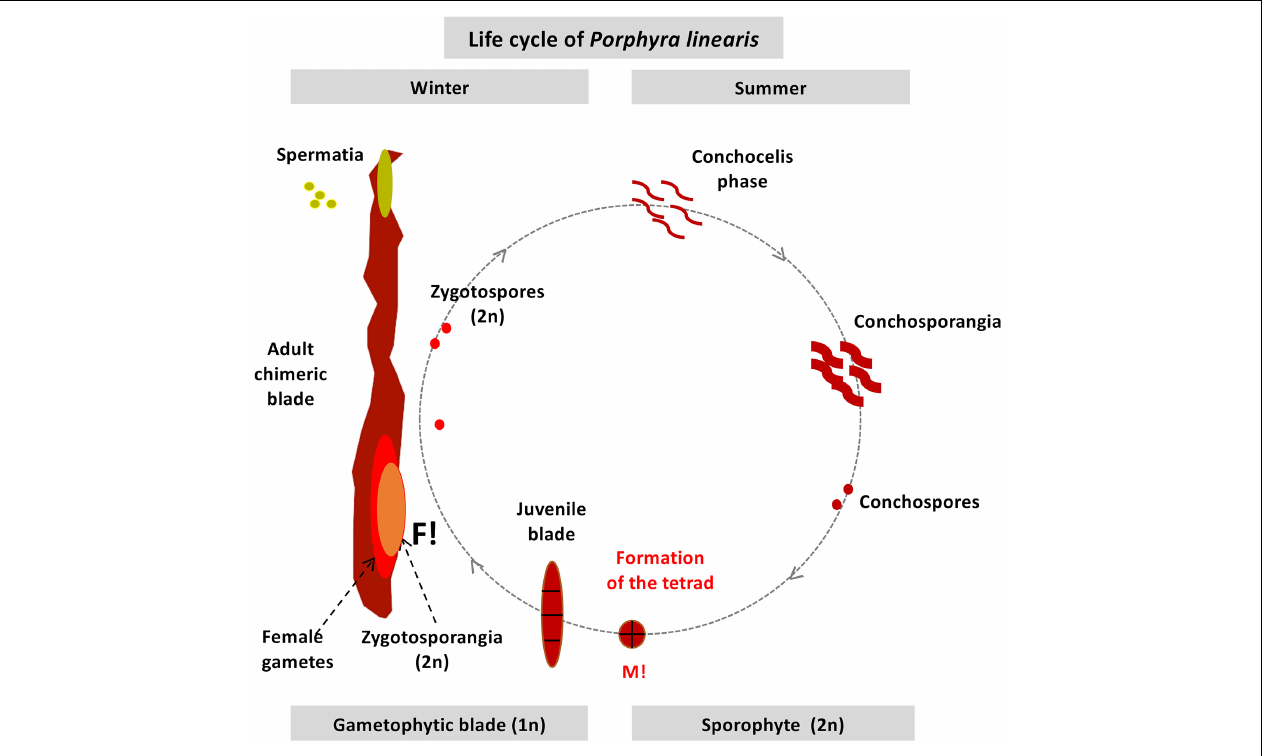
FIGURE 1 | Diagram of the life history in the field of Porphyra linearis . M!: Meiosis. F!: Fertilization (syngamy or fusion of males and females gametes).